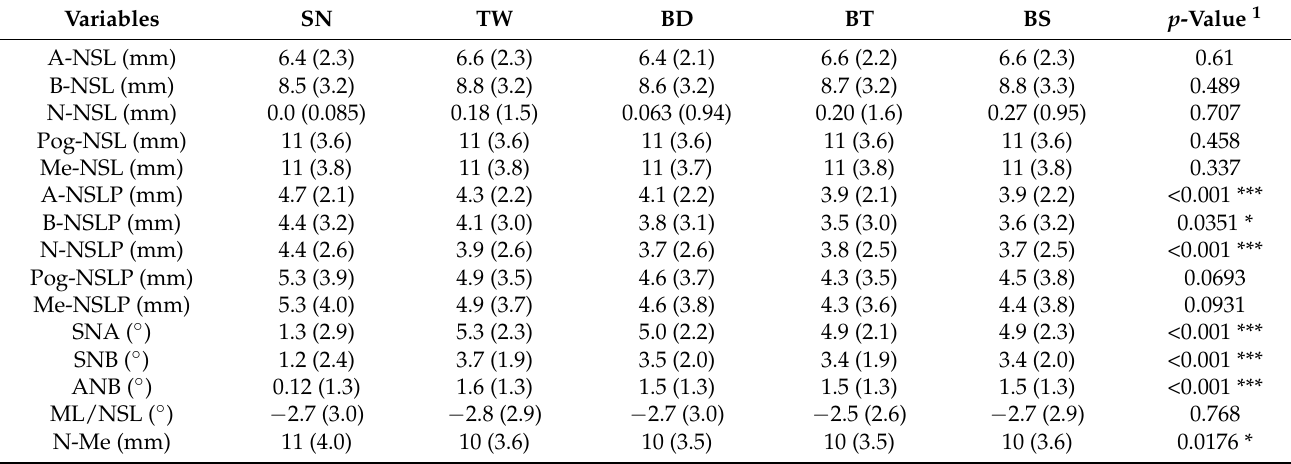
Table 2. Mean changes (standard deviation) for the 15 variables of the whole sample (T2S REF1 − T1C REF1 ) compared for the superimposition methods: SN, TW, BD, BT, and